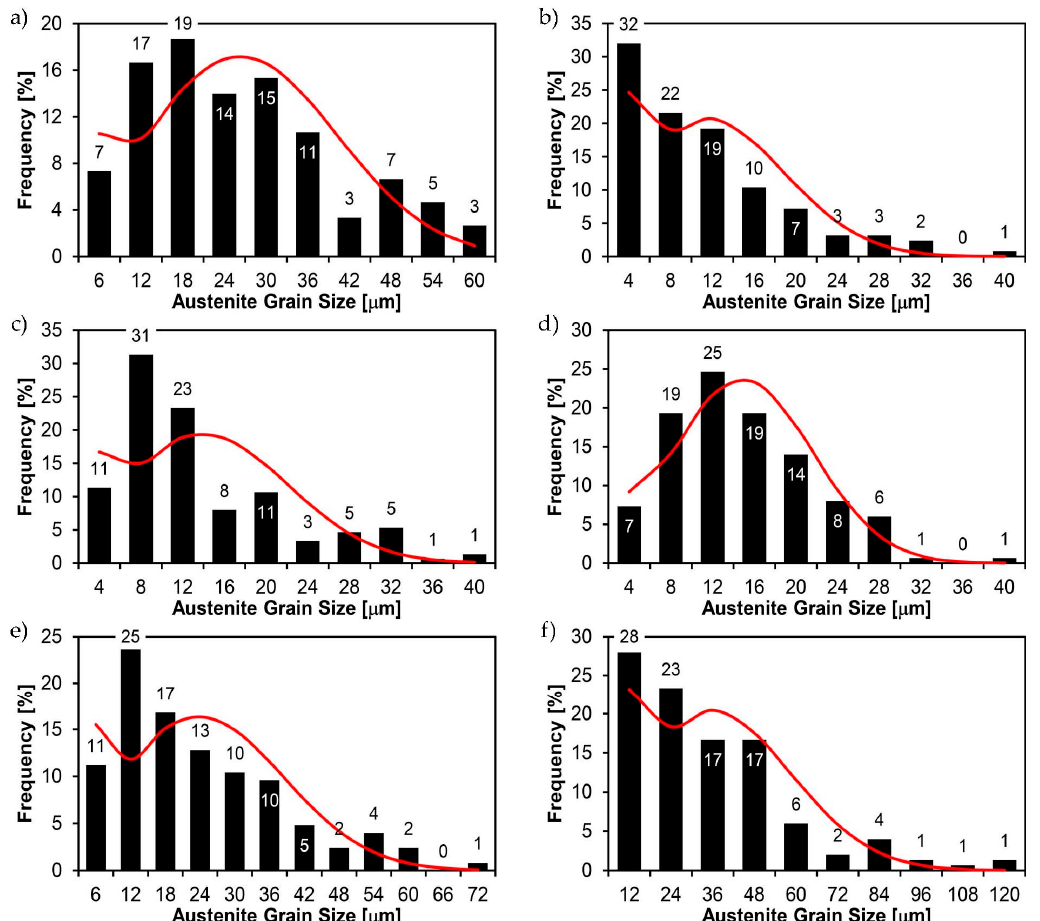
Figure 56. Frequency intervals and normal occurrence distributions of determined grain sizes of prior austenite in the welded joint zone of Hardox 450 steel marked as FL in Figure 2: ( a ) normalised state; ( b ) delivery state (directly after welding); ( c ) after austenitising at 900 ◦ C for 60 min; ( d ) after austenitising at 1000 ◦ C for 60 min; ( e ) after austenitising at 1100 ◦ C for 120 min; ( f ) after austenitising at 1200 ◦ C for 120